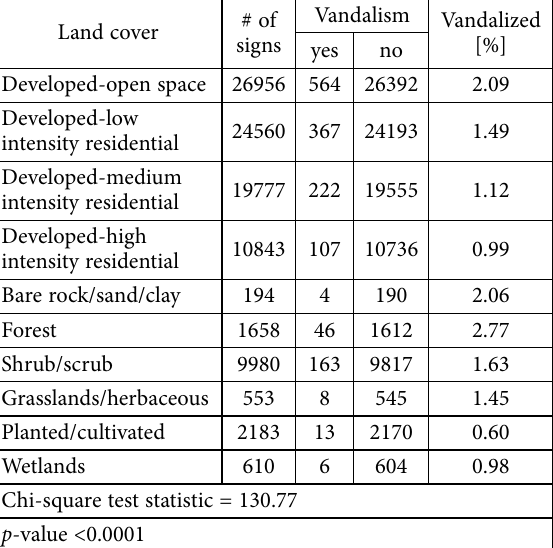
Table 7. Traffic sign vandalism by land cover